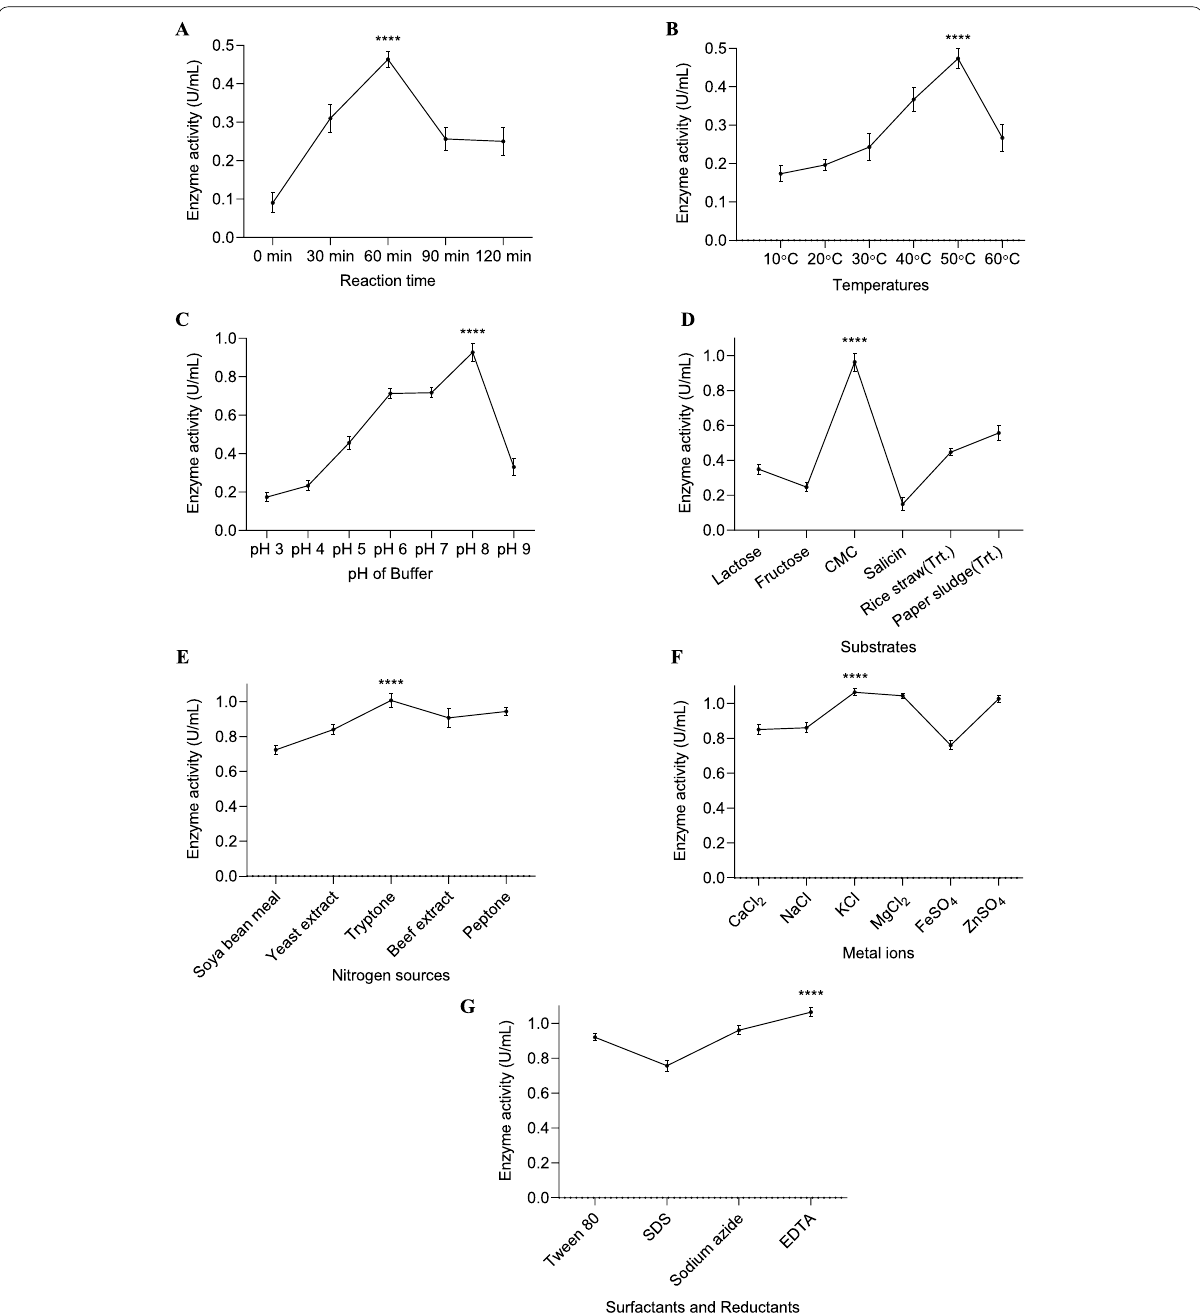
Fig. 6 Effect of A reaction time, B temperature, C pH of buffer, D substrates, E nitrogen sources, F metal ions, and G surfactants and reductants on enzyme activity obtained from A. woluwensis TDS9. Each parameter was kept constant in the following steps upon optimization. **** indicates statistical significance value, P <